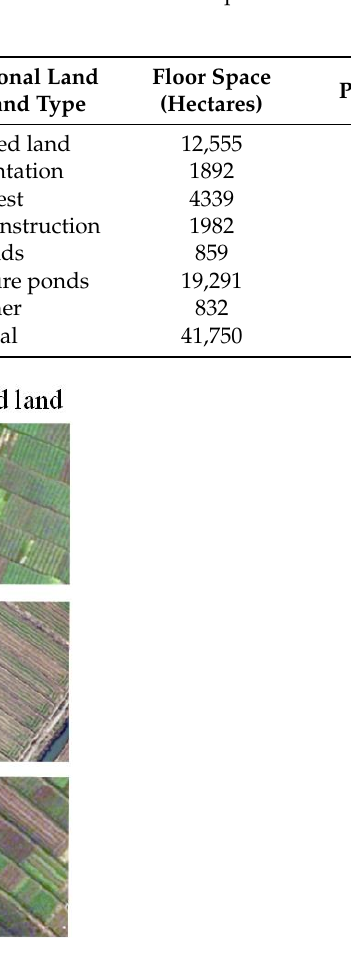
Figure 4. Cultivated land in the third land surveys. ( a1 – a3 ) Paddy fields samples; ( b1 – b3 ) Dry land samples; ( c1 – c3 ) Irrigated land samples.